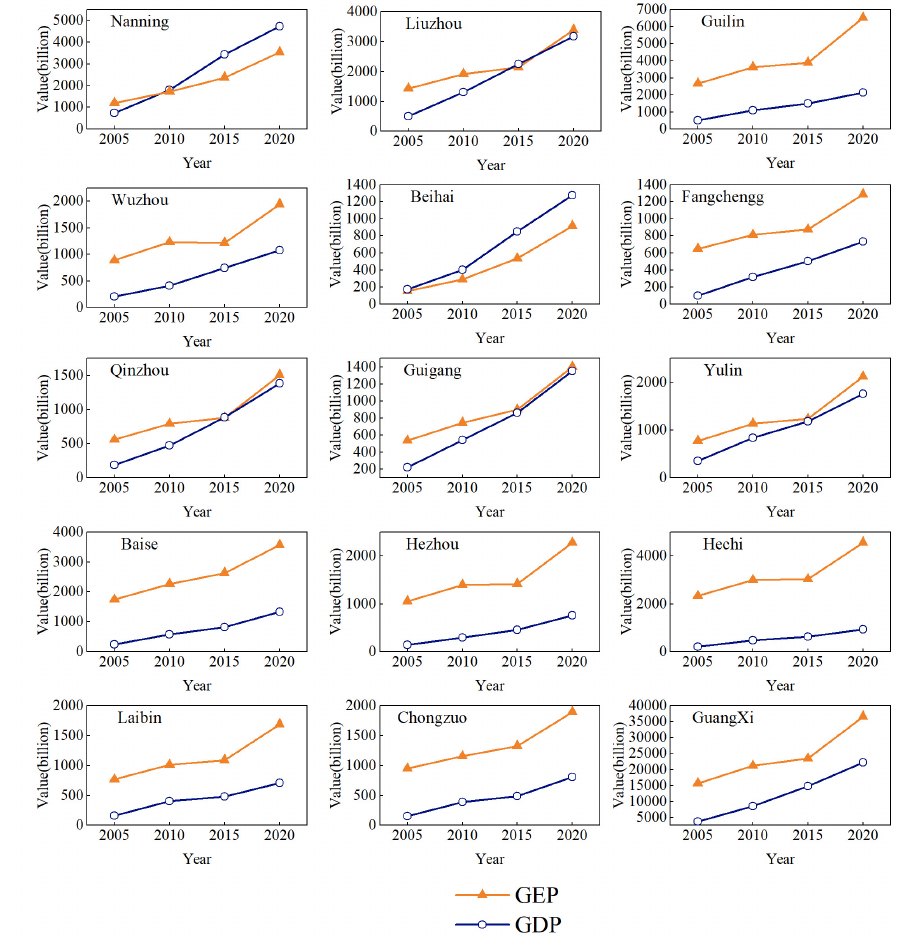
Figure 8. Comparison of GEP and GDP changes in various cities.